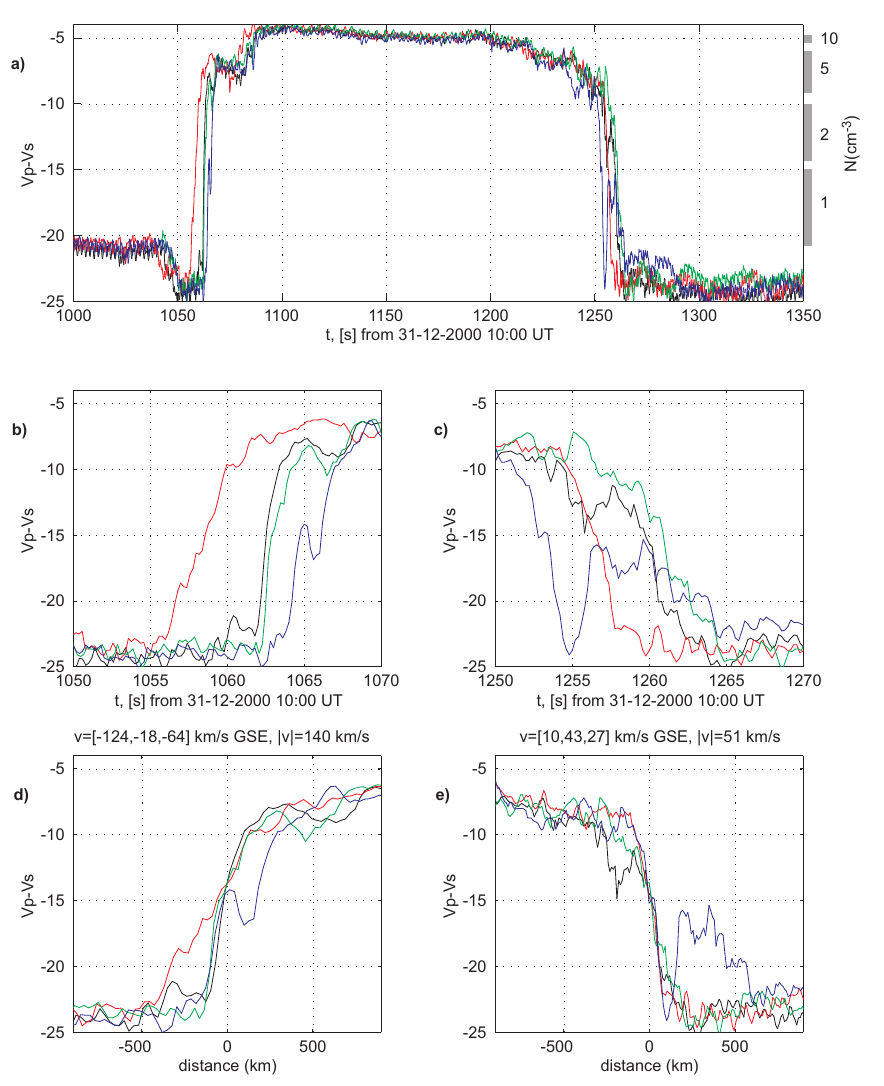
Fig. 4. Time series of the probe to spacecraft potential, V s − V p , for the four Cluster spacecraft (black is space- craft 1, red is spacecraft 2, green is spacecraft 3 and blue is spacecraft 4) are given in panel (a) . Panels (b) and (c) are the same as (a) for selected shorter intervals. Panels (d) and (e) show V s − V p as a function of a distance scale par- allel to an estimated magnetopause nor- mal. The zero on this scale has been placed arbitrarily at the midpoint of the magnetopause boundary layer gradient. The magnetopause velocity vectors, in GSE coordinates, are also given in these two